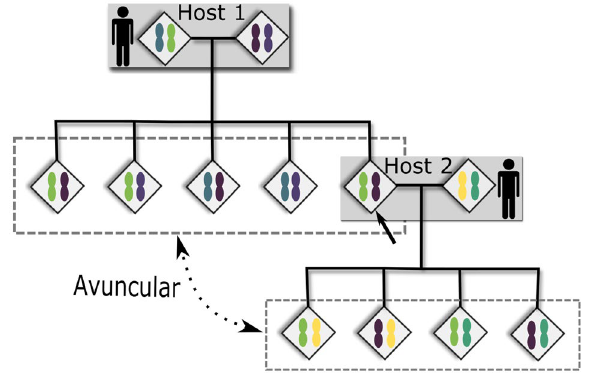
Figure 4. Avuncular relationships among schistosome miracidia. Diamonds indicate schistosomes, with those surrounded by a gray box indicating an adult mating pair, and those surrounded by a dashed box indicating miracidia sibling clutches. Chromosomes within diamonds are colored to indicate different haplotype combinations that could be inherited from parents. The arrow points to a sibling of a miracidia clutch collected from Host 1 that became a parent of another sibling clutch collected from Host 2. This worm is the link that creates the depicted avuncular relationship between the offspring of schistosomes within Host 1 and Host